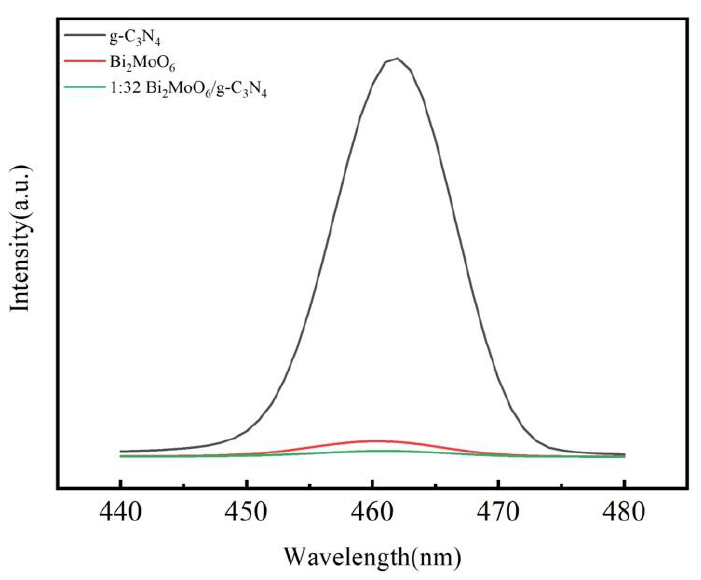
Figure 4. Photoluminescence emission spectra of g-C 3 N 4 , Bi 2 MoO 6 and 1:32 Bi 2 MoO 6 /g-C 3 N 4 .